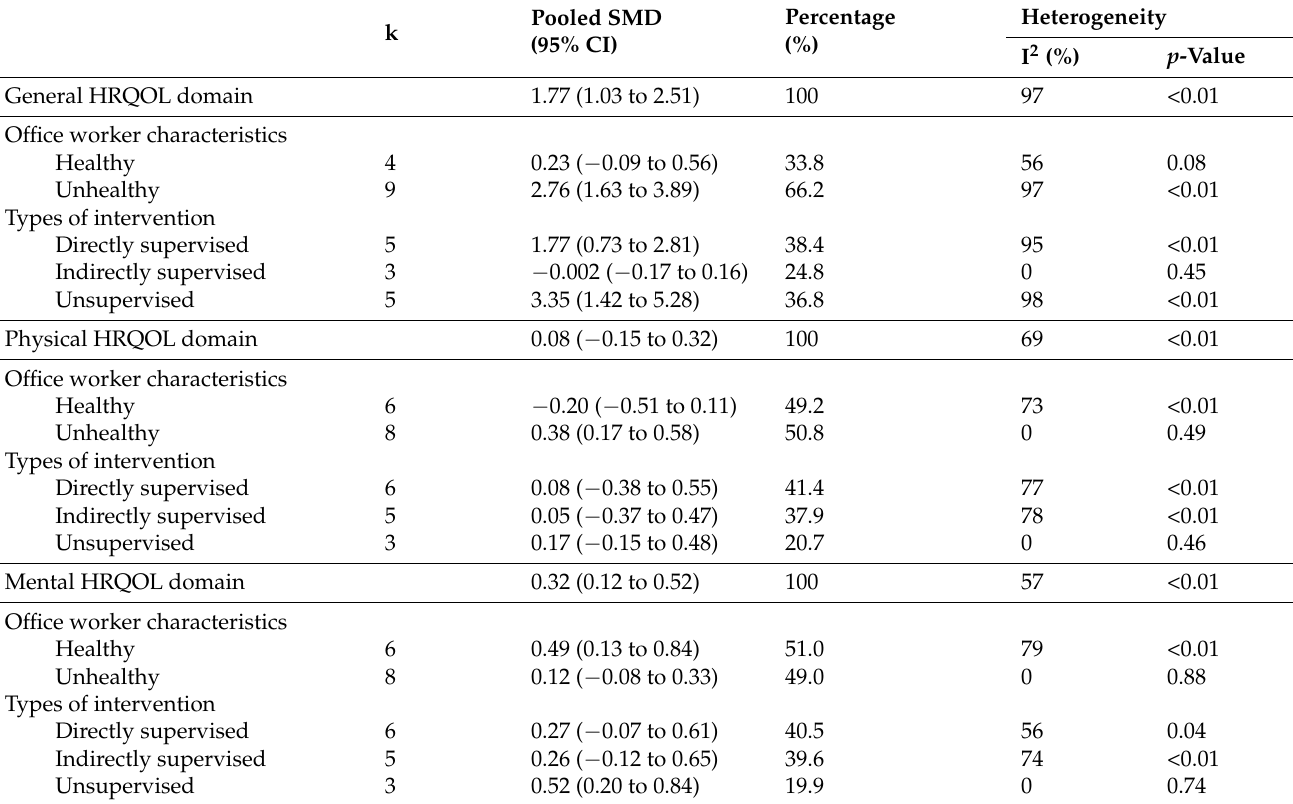
Table 2. The effects of physical exercise on three HRQOL domains in office workers by office worker characteristics and intervention